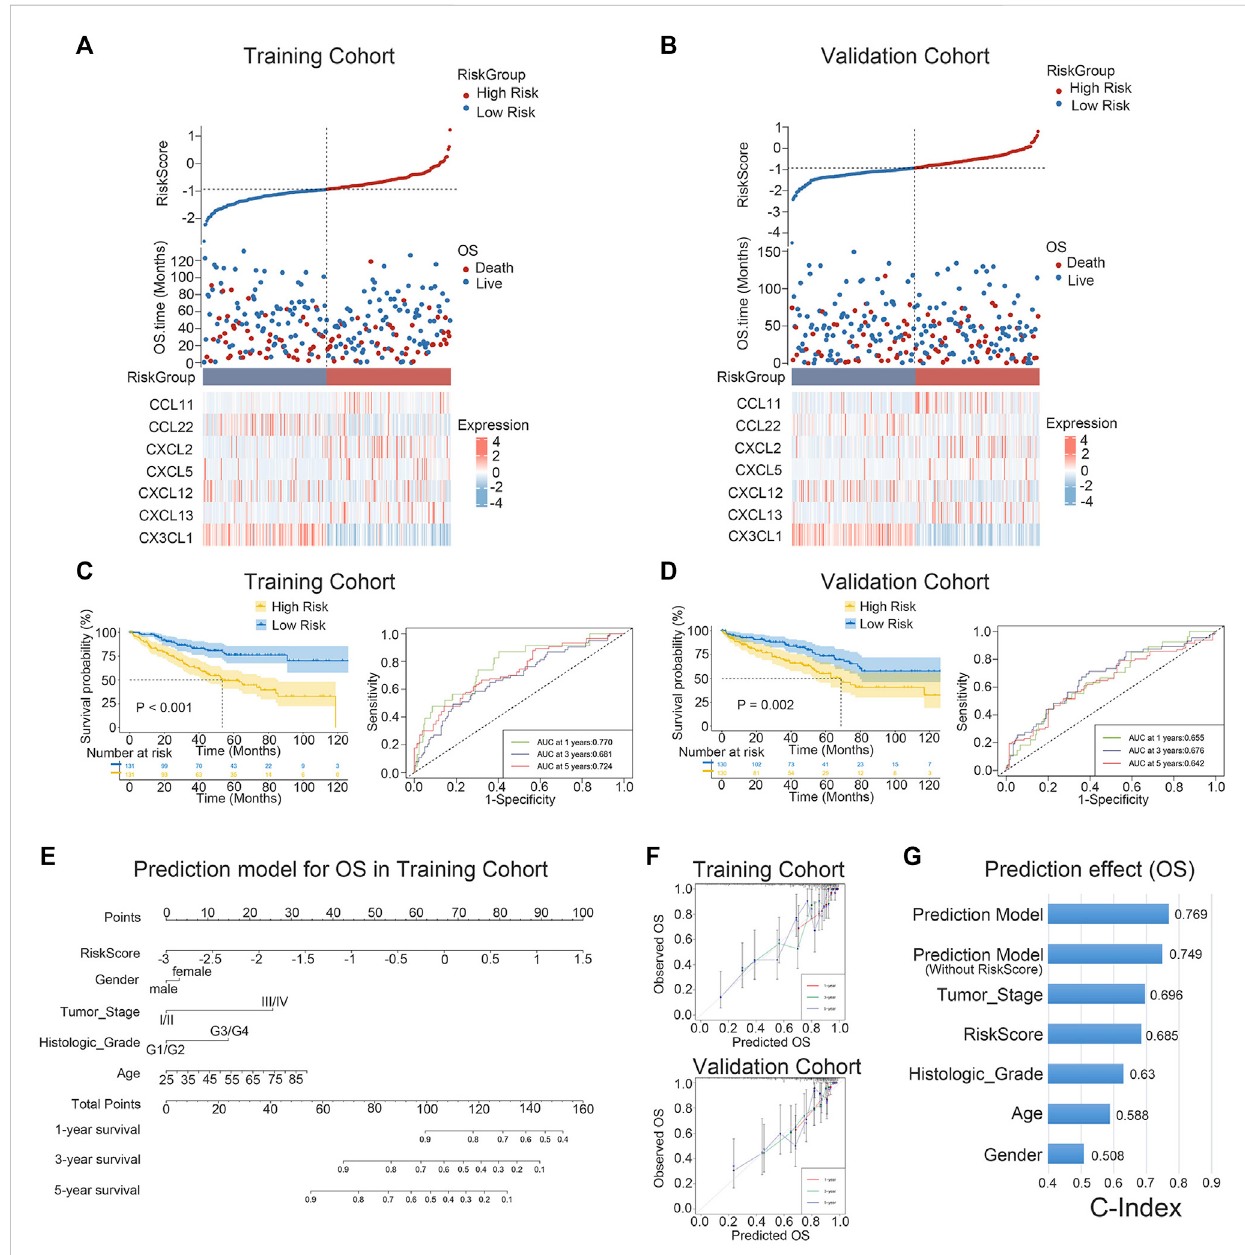
FIGURE 3 K-M survival analysis and nomogram survival prediction. (A, B) Distribution of riskscore, survival status and survival time in ccRCC patients, and heat map of 7 chemokine genes. (C, D) K-M survival curves for OS and ROC curves for 1-, 3-, and 5-year survival rates. (E) Nomogram prediction combining clinicopathological features and riskscore. (F) Predicted and observed 1-year, 3-year and 5-year survival in calibration plots for training and validation cohorts. (G) The C-index is used to visualize the predictive effect of predictive model, riskscore, predictive model without riskscore, and clinicopathological